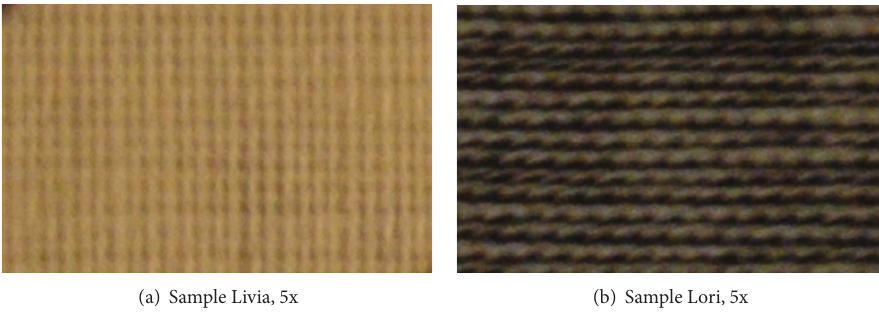
Figure 6: Weaves from cotton in warp and flax in weft. Table 3: The degree of crimping of yarns in the jute